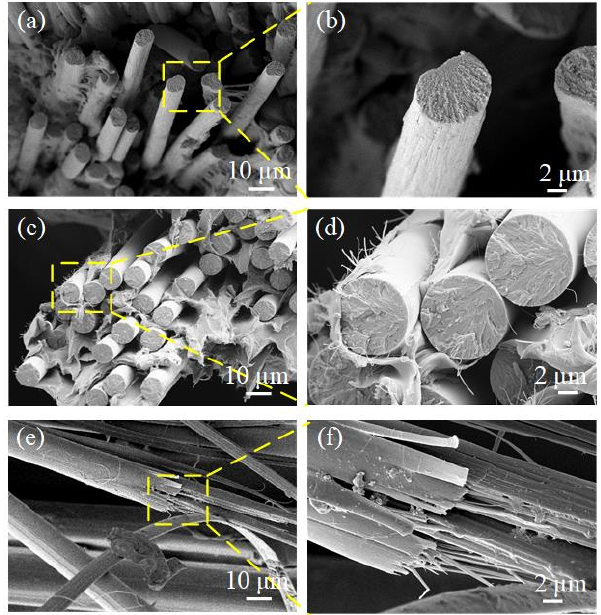
Figure 7. SEM micrographs of three kinds of fractured surface: ( a , b ) carbon fiber, ( c , d ) glass fiber, ( e , f ) Kevlar fiber.